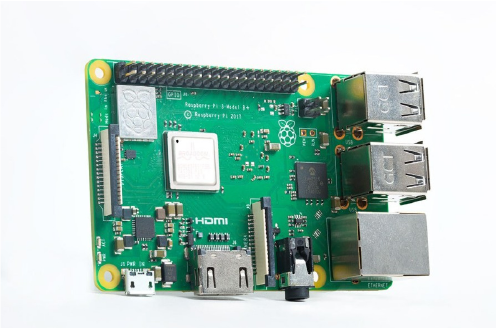
Figure 3. WiFi wireless sensor network (WSN) development board Raspberry Pi 3B+